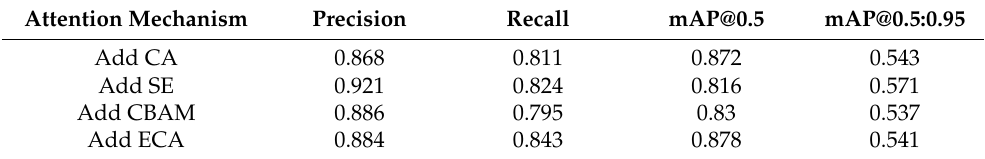
Table 4. Comparison of the models with the four attention modules CA, SE, CBAM, and ECA added to the C3 module of the Neck